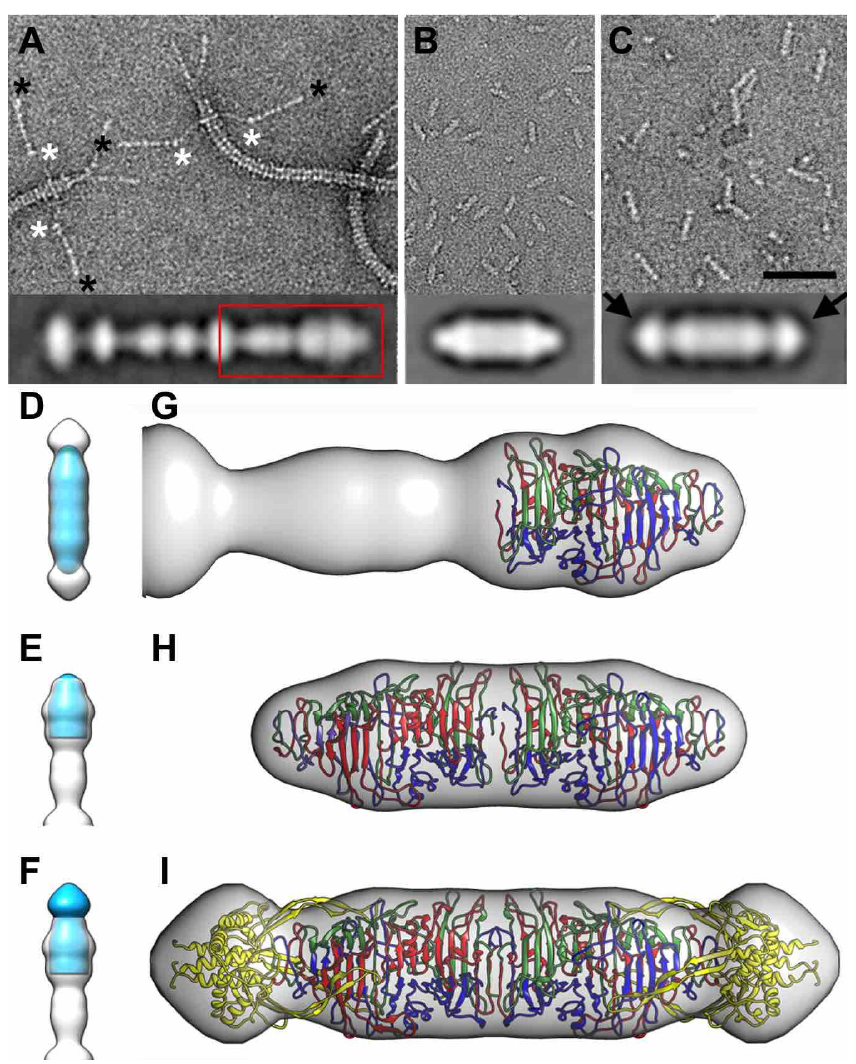
Figure 7. Electron microscopy of the bacteriophage T5 tail and expressed pb1 distal domains. ( A ) Negatively stained T5 tails, in which the some of the distal ends of the L-shaped fibres are indicated with black asterisks and the apparently flexible hinge, or kink, with white asterisks. The scale bar in (C) corresponds to 50 nm; parts (A) and (B) are at the same scale; ( B ) EM of expressed and purified pb1(970–1263); ( C ) EM of expressed and purified pb1(970–1396), i.e. , including the carboxy-terminal intra-molecular chaperone domain. Two-dimensional averages of side views of each T5 tail assembly are shown (bottom insets). The red rectangle highlights the most distal region of the tail fibre shown in parts (E), (F) and (G). Both types of purified protein associate into tail-to-tail dimers of trimers. The intra-molecular chaperone domain is clearly present on the ends of the protein in the right panel, as indicated by arrows; ( D ) Three-dimensional model of pb1(970–1263) (blue) superimposed on the three-dimensional model of pb1(970–1396) (transparent); ( E ) Three-dimensional half-model of pb1(970–1263) (blue, cropped at the longitudinal midpoint) superimposed on the three-dimensional model of the end of the L-shaped tail fibre end (transparent); ( F ) Three-dimensional half-model of pb1(970–1396) (blue, cropped at the longitudinal midpoint) superimposed on the three-dimensional model of the end of the L-shaped tail fibre end (transparent); ( G ) Three-dimensional model of the most distal region of the L-shaped tail fibre distal domain with the trimeric pb1(970–1263) atomic model docked at the tip; ( H , I ) Three-dimensional models of the trimer-dimers of pb1(970–1263) (H) and pb1(970–1396) (I) with their corresponding atomic models docked.